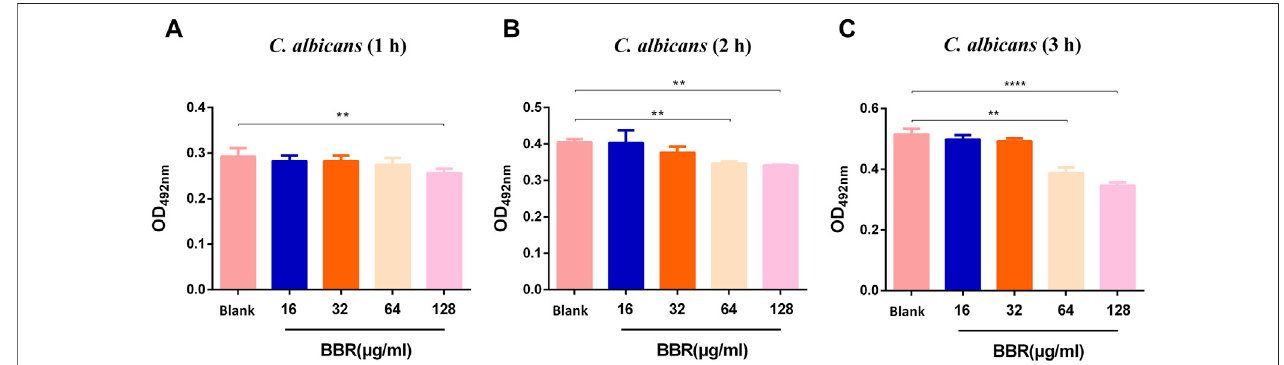
FIGURE1| EffectofdifferentconcentrationsofBBRontheviabilityof C.albicans at (A) 1 h (B) 2 h,and (C) 3 h.Thedrug-freestrain-containingmediumwassetas the Blank. The drug concentration of treatments was as follows: Blank, 16 µg/ml BBR, 32 µg/ml BBR, 64 µg/ml BBR and 128 µg/ml BBR. Data are shown as mean